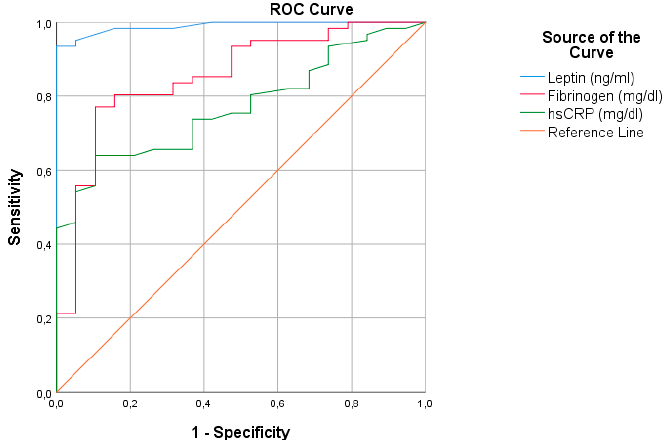
Figure 1. ROC curve of threshold leptin, hs-CRP and fibrinogen levels for predicting VO 2max (sensitivity versus specificity). hsCRP , high sensitivity C-reactive protein; ROC , receiver operating characteristic; VO 2max , maximal aerobic